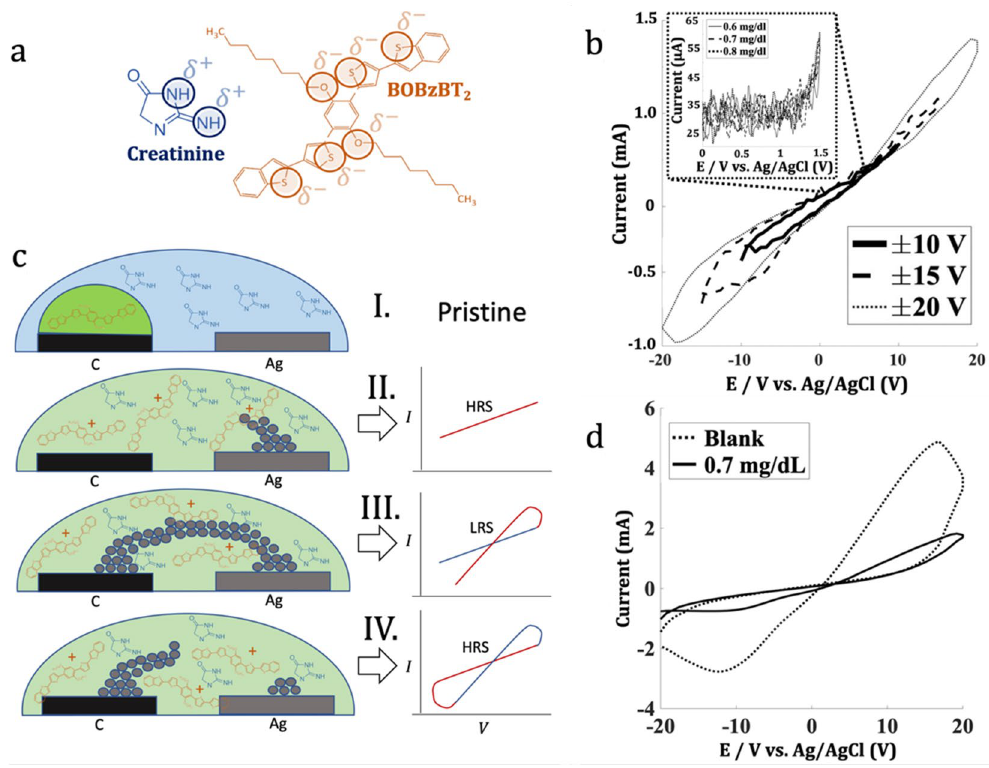
Figure 2. ( a ) The possible interaction sites between BOBzBT 2 pentamer and creatinine molecule. ( b ) The CV measurement using creatinine concentration of 0.9 mg dL −1 at different voltages. The pinched hysteresis loop only is emerged when using ± 20 V. The inset showed attempted CV measurement at 0–1.5 V voltage range on three different concentrations of creatinine. ( c ) The RS mechanism concerning the formation of HRS and LRS,